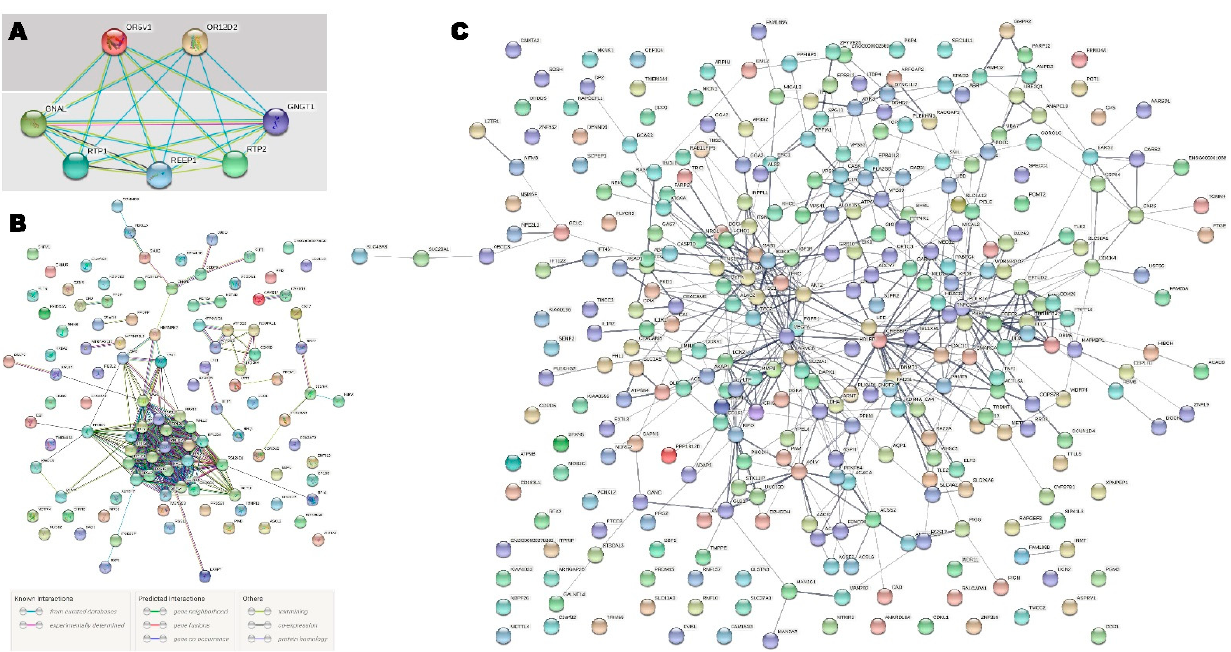
Figure 4. ( A ): Protein–protein interaction based on the predictive model and predicted functional partners of the OR12D2 and OR5V1 proteins using the STRING database, version 10. ( B ): Significantly upregulated genes and their interaction. Number of edges: 77 and the PPI enrichment p ‐ value < 1.0 × 10 − 16 . ( C ): Significantly downregulated genes ( p ‐ value < 0.001) and their interaction. Number of edges: 420 and the PPI enrichment p ‐ value = 2.05 × 10 − 06 . Table 6. Associated KEGG pathway enrichments of the significantly up ‐ and downregulated genes.